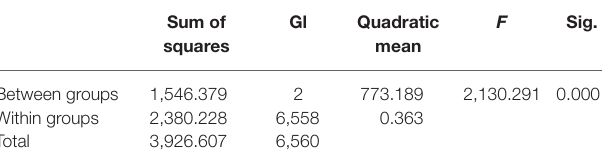
TABLE 5 | ANOVA test between cognitive level and country of